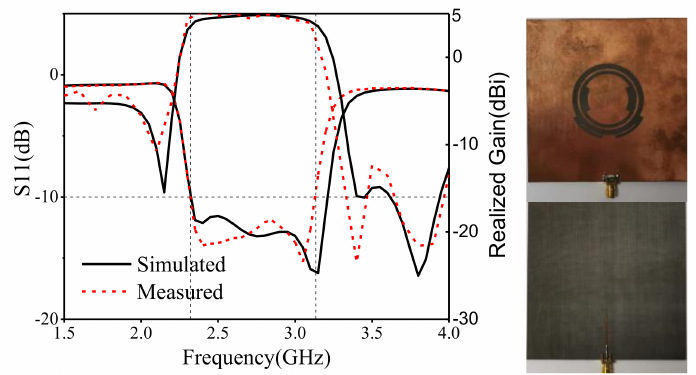
Figure 12. Comparisons of the simulated/measured S11 and realized gain, prototype of the antenna.